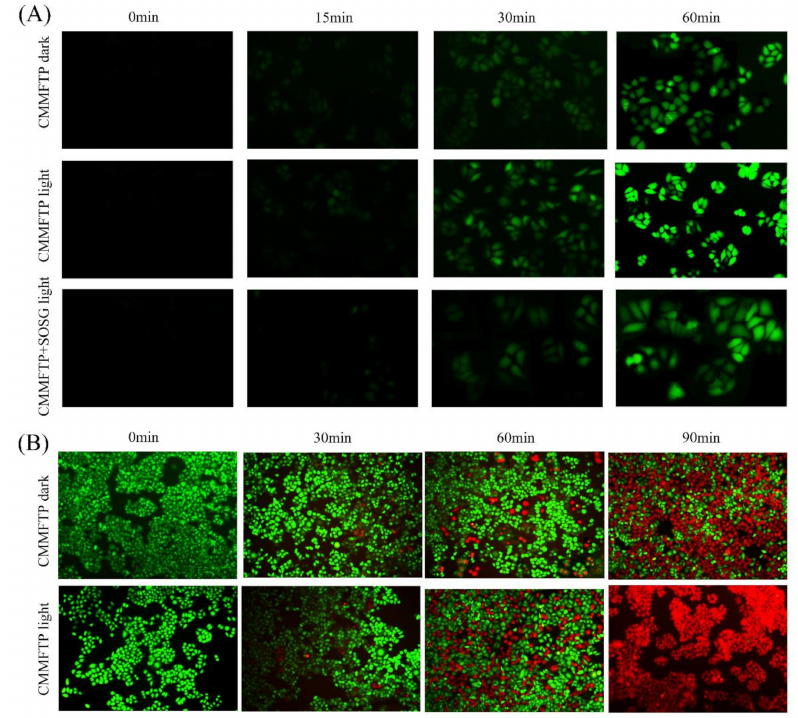
Figure 4. ( A ) Detection of intracellular ROS; ( B ) calcein-AM and PI co-staining of living and dead